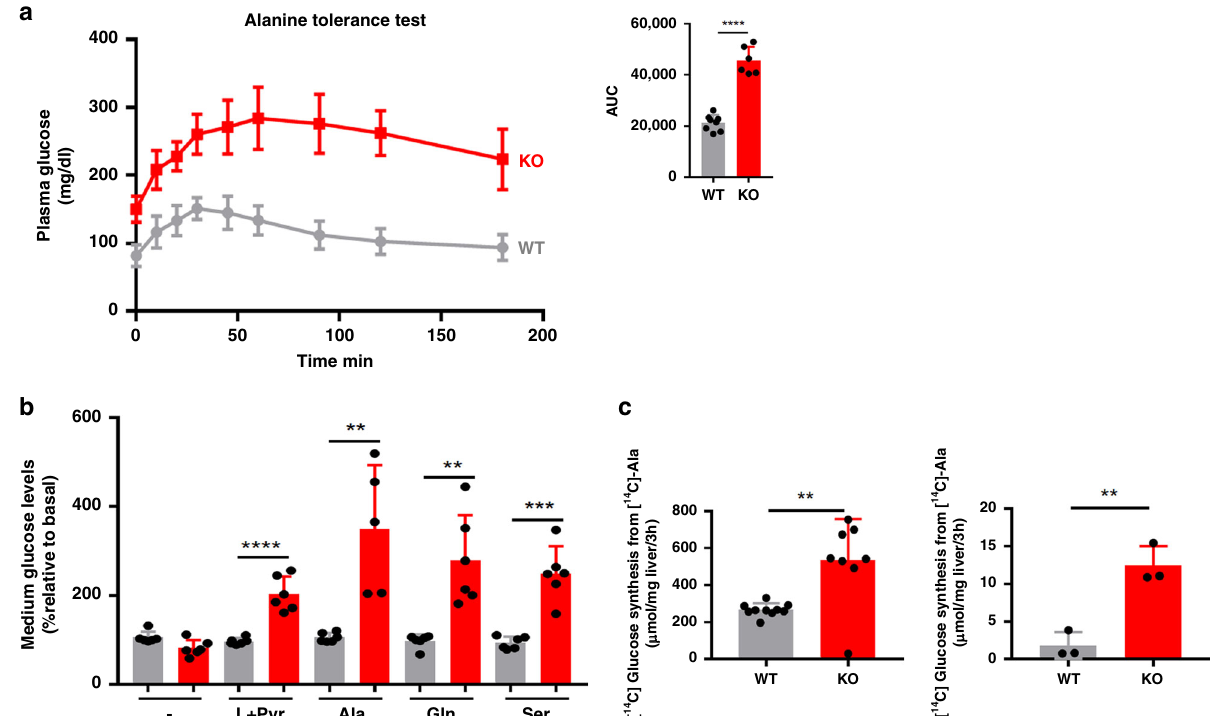
Fig. 4 Liver gluconeogenesis from amino acids in Lkb1KO livad (KO) mice. a Blood glucose levels in alanine tolerance test (KO, n = 6, WT: n = 8). The area under the curve (AUC) of glucose level is shown. Mice were fasted for 24 h before the ATT. Data are presented as mean values ± SD. P values were determined by unpaired two-tailed t -test. *** p ≤ 0.001. b Glucose production from glutamine, alanine or serine in primary cultures of hepatocytes. Glucose production was normalized against protein content and is expressed as a percentage of the glucose produced by WT hepatocytes incubated in the absence of gluconeogenic substrates. Data are means ± SD of six biologically independent cell culture. P values were determined by unpaired two-tailed t -test. ** p ≤ 0.01; *** p ≤ 0.001. c [ 14 C]-glucose and [ 14 C]-glycogen synthesis from [ 14 C]-alanine in cultured liver explants from fasted mutant (KO, n = 3) and fasted control (WT, n = 3) mice. Data are means± SD. P values were determined by unpaired two-tailed t -test. ** p ≤ 0.01. For all the experiments described in this fi gure, animals were analyzed 15 days after the injection of tamoxifen. Source data are provided as a Source data fi